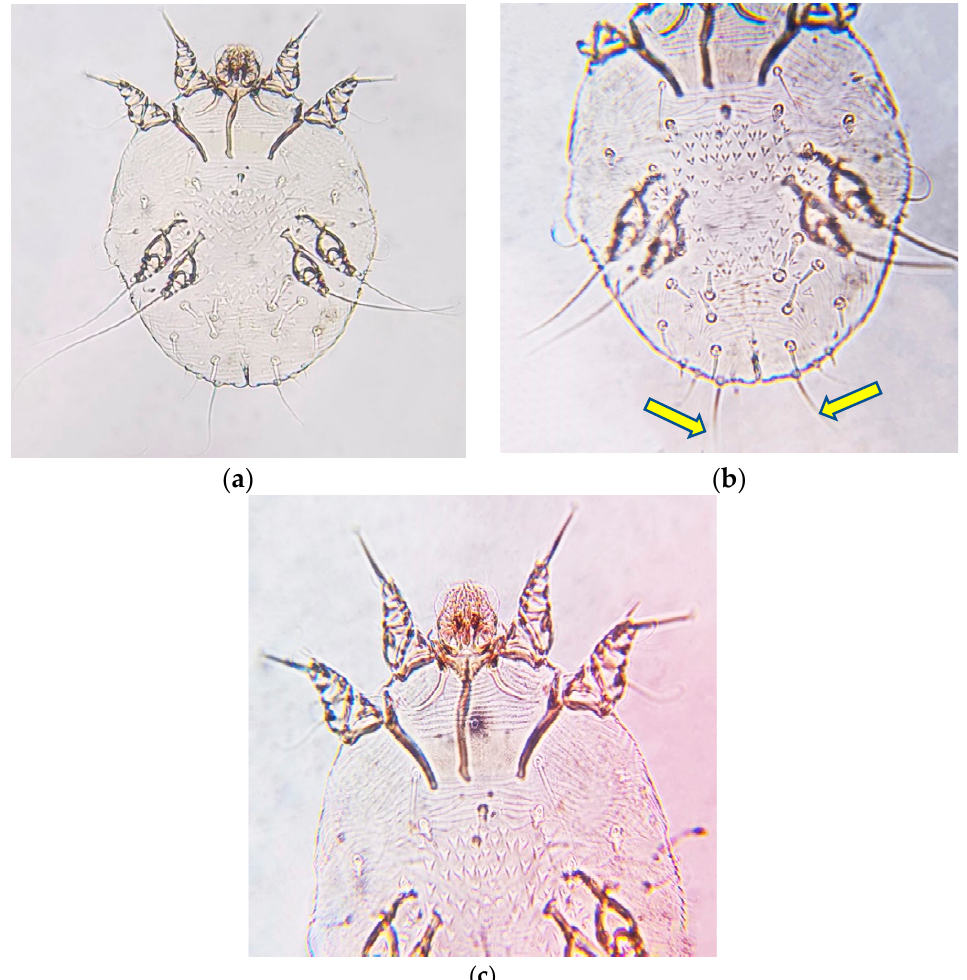
Figure 1. Mite identity: ( a ) Overview of the body shape of the itch mite, Sarcoptes scabiei var. cuniculi ; ( b ) Idiosoma with the cuticular spines in the middle; ( c ) Short capitulum of the itch mite, Sarcoptes scabiei var. cuniculi .